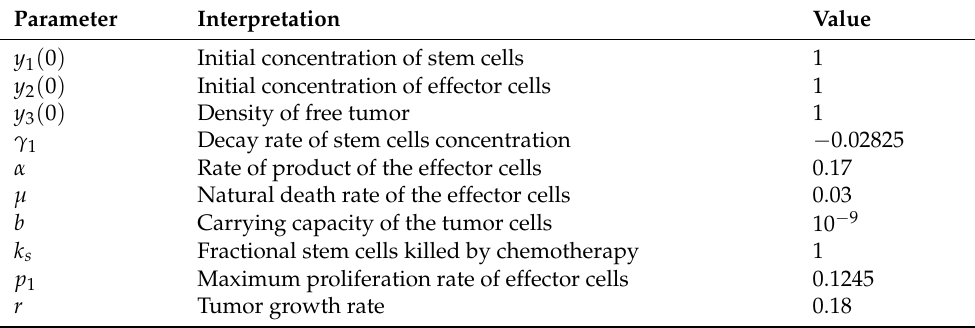
Table 2. Parameter values in different models of drug concentration.